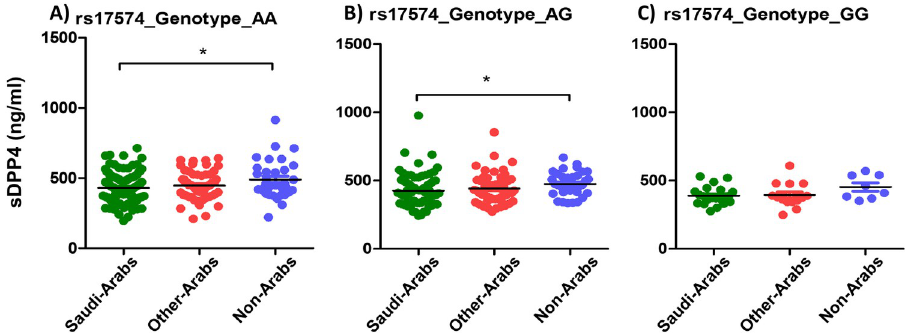
Fig 6. Average sDPP4 levels among different ethnic groups in relation to the rs17574 genotypes.